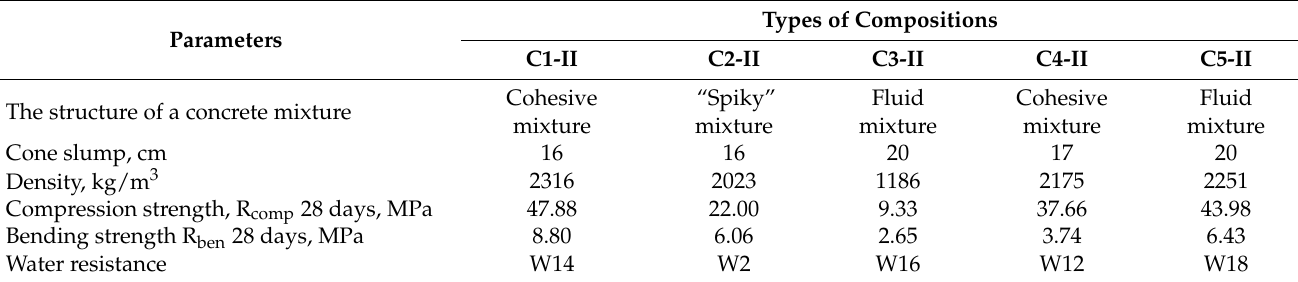
Table 8. Test results in the second line of research.